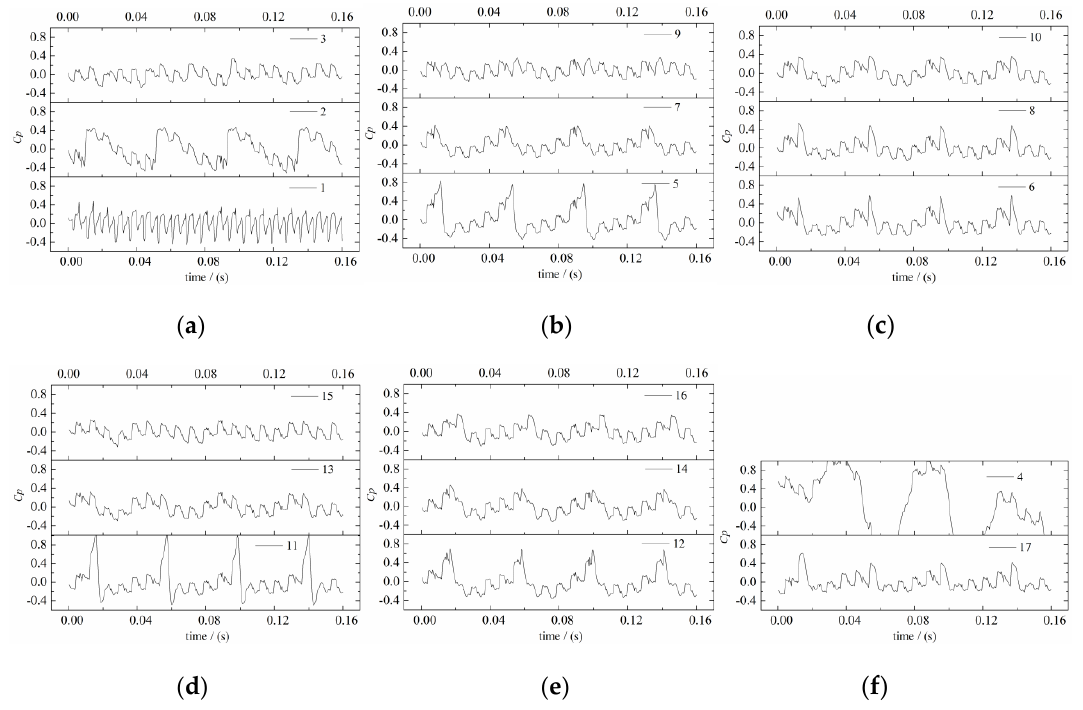
Figure 10. Pressure fluctuation coefficient with time. ( a ) Points 1, 2, 3; ( b )Points 5, 7, 9; ( c )Points 4, 6, 8; ( d )Points 11, 13, 15; ( e )Points 12, 14, 16; ( f )Points 4, 17.